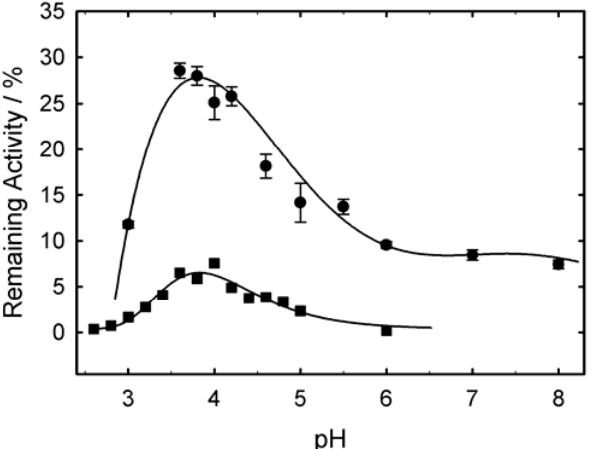
Figure 5. Influence of the pH value of the adsorption solution on the activity of CPO ( ■ ) and GOx ( ● ) adsorbed on SBA-15. Activity values are given in percent of initial CPO activity in solution which was determined using the MCD assay as described in